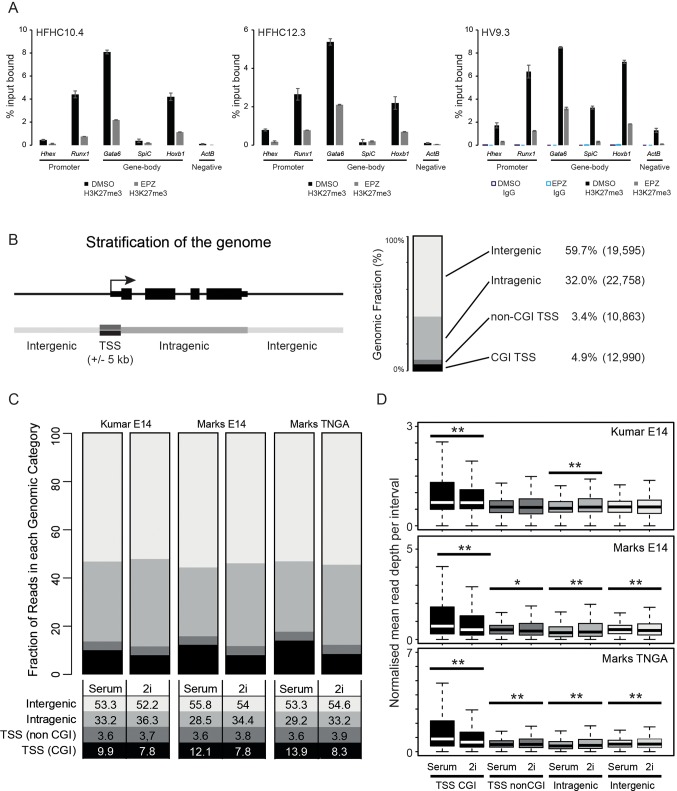
Reduction and redistribution of H3K27me3 in ESCs treated with EPZ and 2i, respectively.(A) Barplots showing quantitative H3K27me3 ChIP-PCR from ESCs treated for 24h with either DMSO or EPZ (black and grey bars respectively). ChIP was performed in 3 independent Hhex reporter ESC lines (HFHC10.4, HFHC12.3 and HV9.3) and anti IgG ChIP was performed for clone HV9.3 as a negative control. Error bars represent the standard deviations for duplicated PCR reactions. (B) Schematic representation of the segmentation used to stratify the genomic distribution of H3K27me3 signal (left panel) and a barplot showing the fraction of the genome covered in each category (right panel). The genome is categorized into: CGI TSS (black; ± 5 kb), non-CGI TSS (dark grey; ± 5 kb), intragenic (grey) and intergenic (light grey). The percentage of the genome and the number of intervals representing each category are shown. (C) Barplot depicting the distribution of H3K27me3 ChIP-seq signal across each category as a percentage of total mappable reads for three independent datasets. Percentages for each category are tabulated below the plot. (D) Boxplots depicting the normalised read depths per genomic interval for each genomic fraction. The significance of increased/decreased signal was determined using a Wilcoxon rank-sum test and significant values are indicated (0.05>p≥0.01* and p<0.01**). Significant p values indicated*/** are 2.84 × 10–5, 1.45 × 10–14, 3.39 × 10–54, 9.7 × 10–3, 3.88 × 10–8, 1.1 × 10–20, 2.98 × 10–174, 3.72 × 10–4, 4.36 × 10–7 and 1.04 × 10–4 (in order from top-left to bottom-right by row).